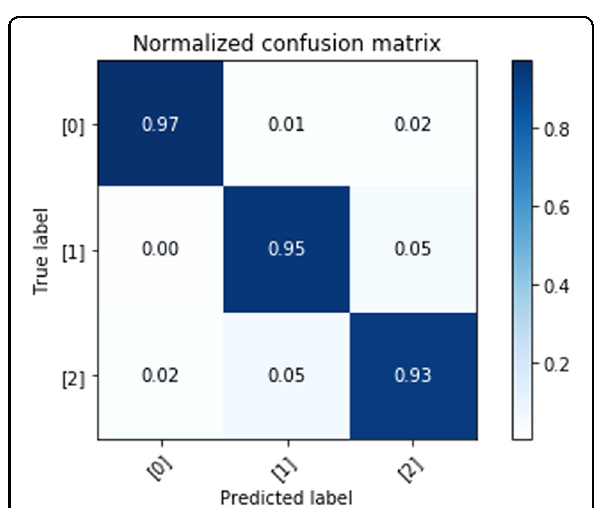
Fig. 3 Normalized confusion matrix for HHI evaluation utilizing visual metrics and CNN-LSTM algorithm. Element value (m, n) of this matrix, and color, represent the probability of predicted HHI level n, given the ground-truth HHI level m, where m and n have labels of 0 (low), 1(intermediate/controllable), and 2 (high). The diagonal elements of this matrix correspond to correct predictions.